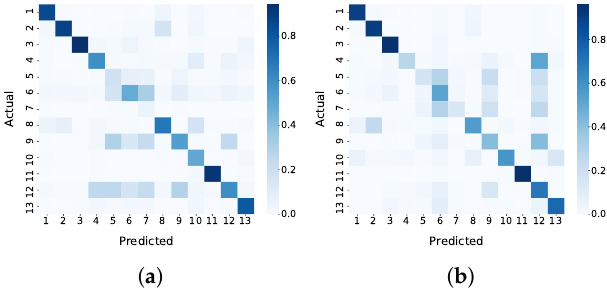
Figure 7. Confusion matrices for TripletLSTM-1 in terms of precision and recall. ( a ) Precision confusion matrix of TripletLSTM-1. ( b ) Recall confusion matrix of